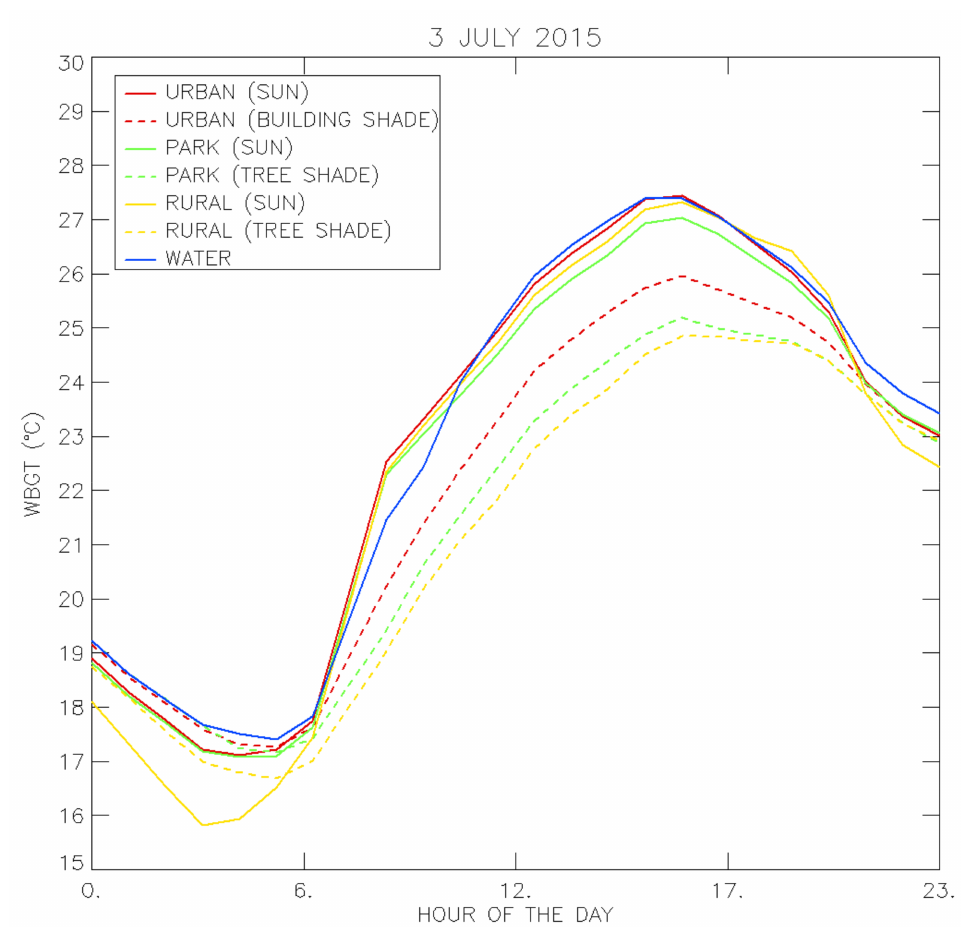
Figure 4. Daily cycle of modelled wet bulb globe temperatures with an hourly time resolution, averaged per land use class for the focus area. A distinction is made between unshaded (full lines) and fully shaded (dashed lines)